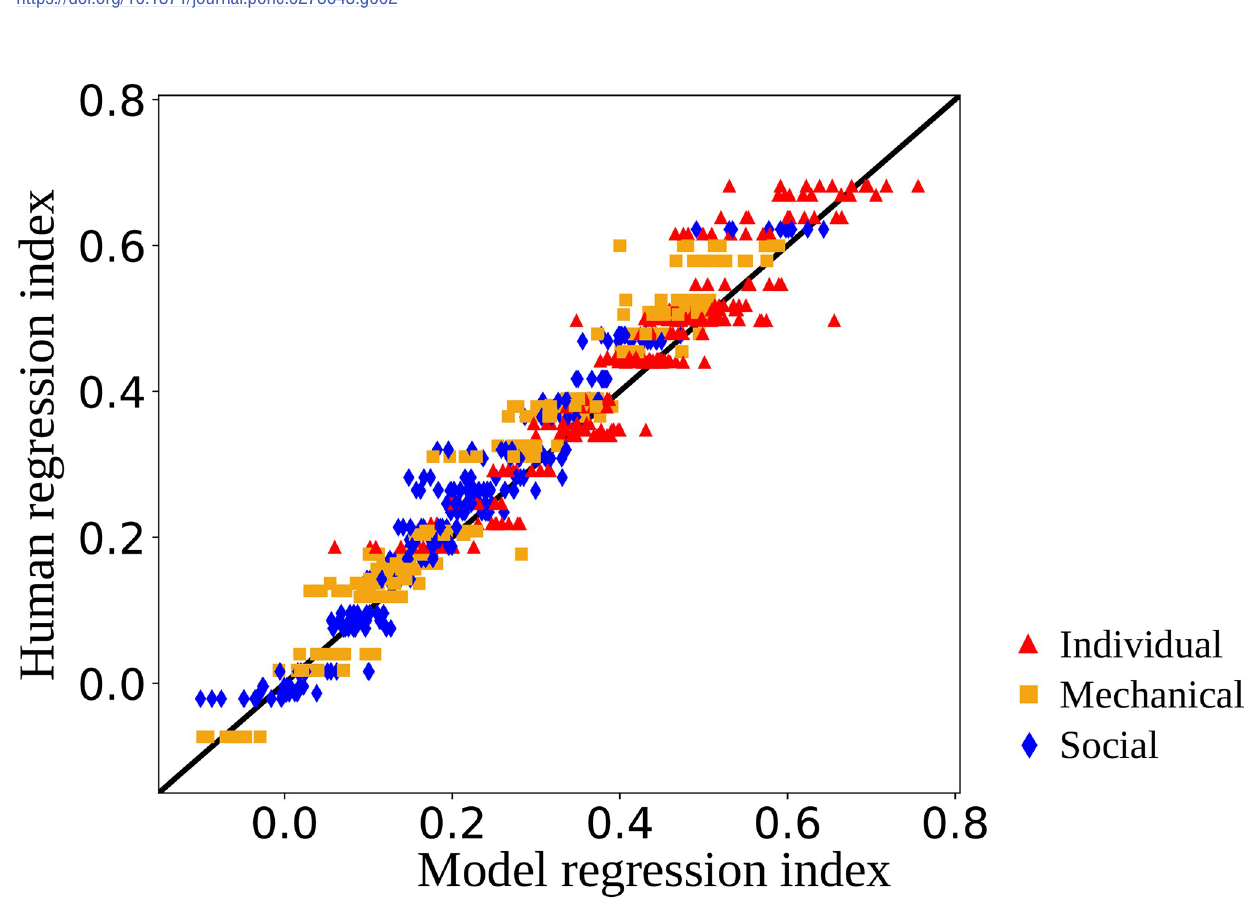
Fig 3. The regression indices of the human plotted against the regression indices of all trained networks for reproducing all training data.